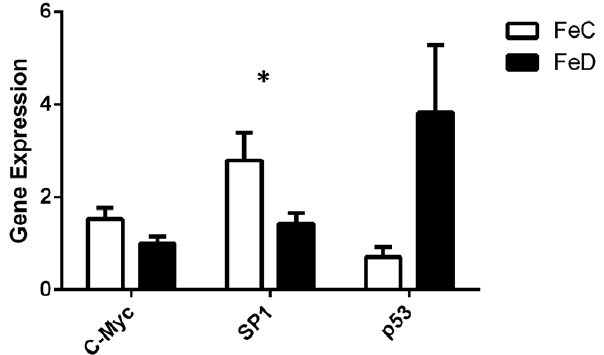
Figure 2. Transcription factor expression in embryos exposed to control (FeC) and iron deficient (FeD) diets, measured by RT- PCR and normalised with Oligreen; data shown as mean 6 SE; n=8; *P , 0.05.